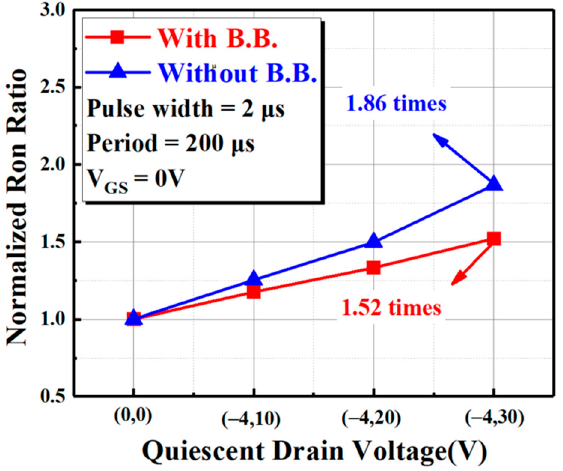
Figure 5. Dynamic R on ratio of the two devices.